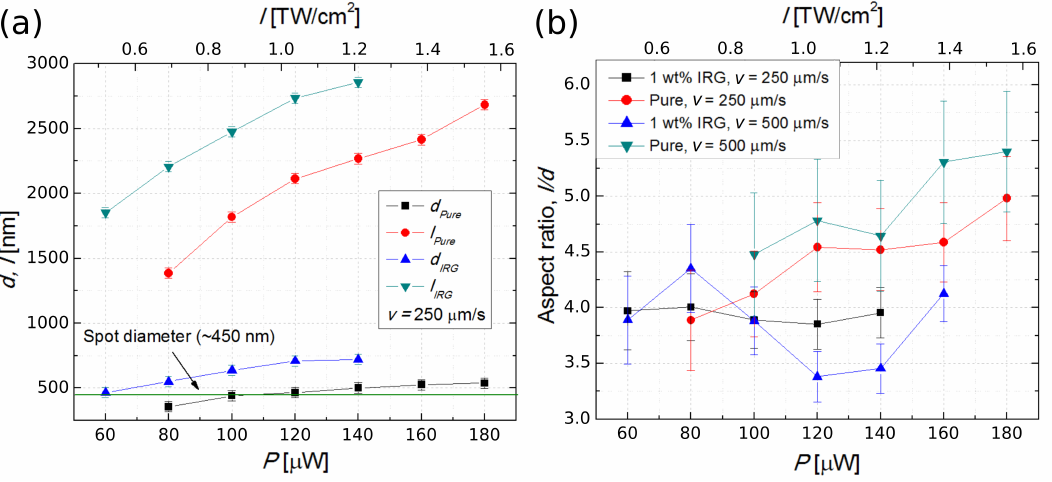
Figure 3. ( a ) feature width d and height l measured in the resolution array at writing speed of 250 µ m/s; and ( b ) aspect ratio of lines produced for cases of 250 µ m/s and 500 µ m/s